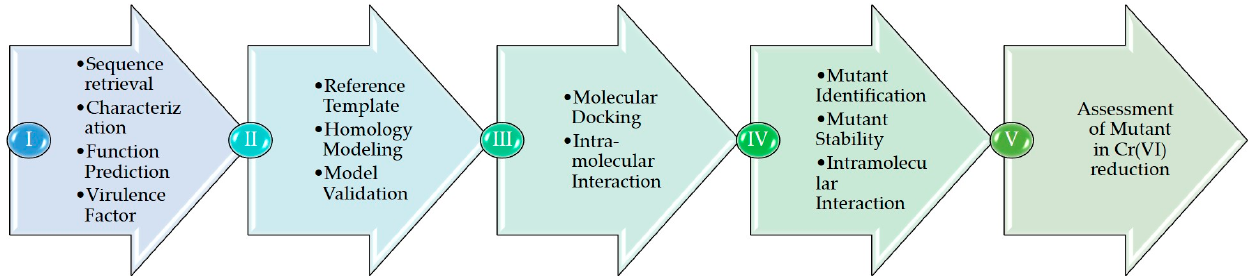
Figure 1. Computational framework applied to analyze Cr(VI) to Cr(III) reduction by ChrR from P. alcalifaciens.